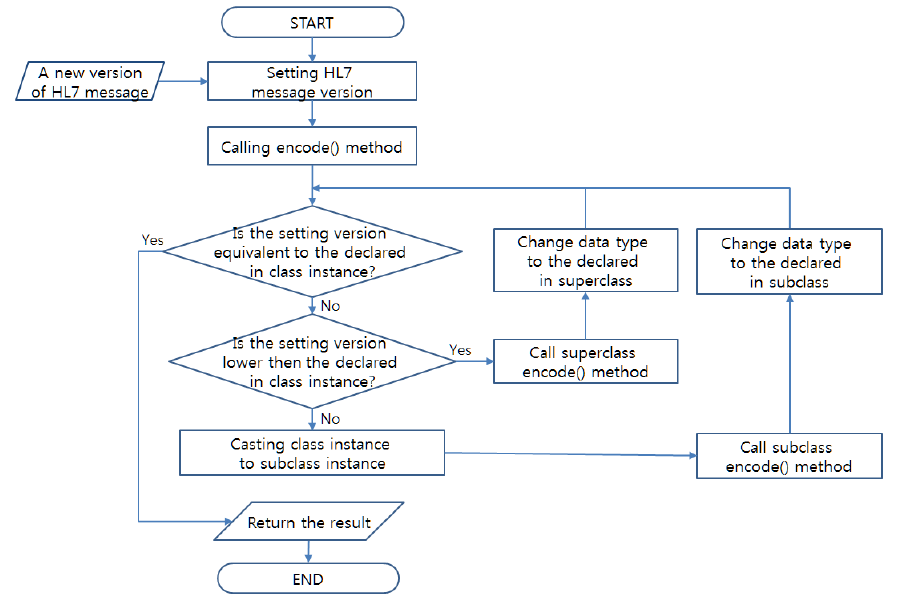
Fig. 11. Flow chart for converting HL7 message as given version.